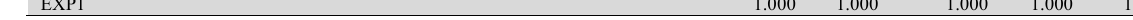
The results of HTMT value